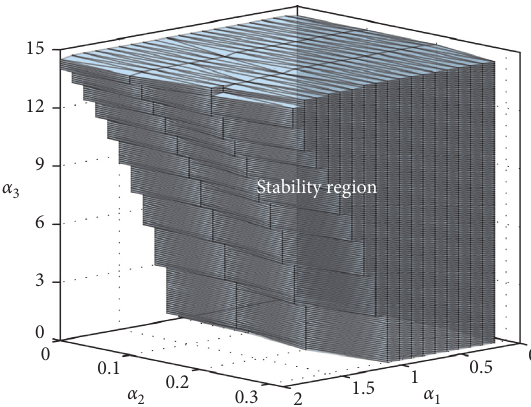
Figure 16: The stability region of E g �